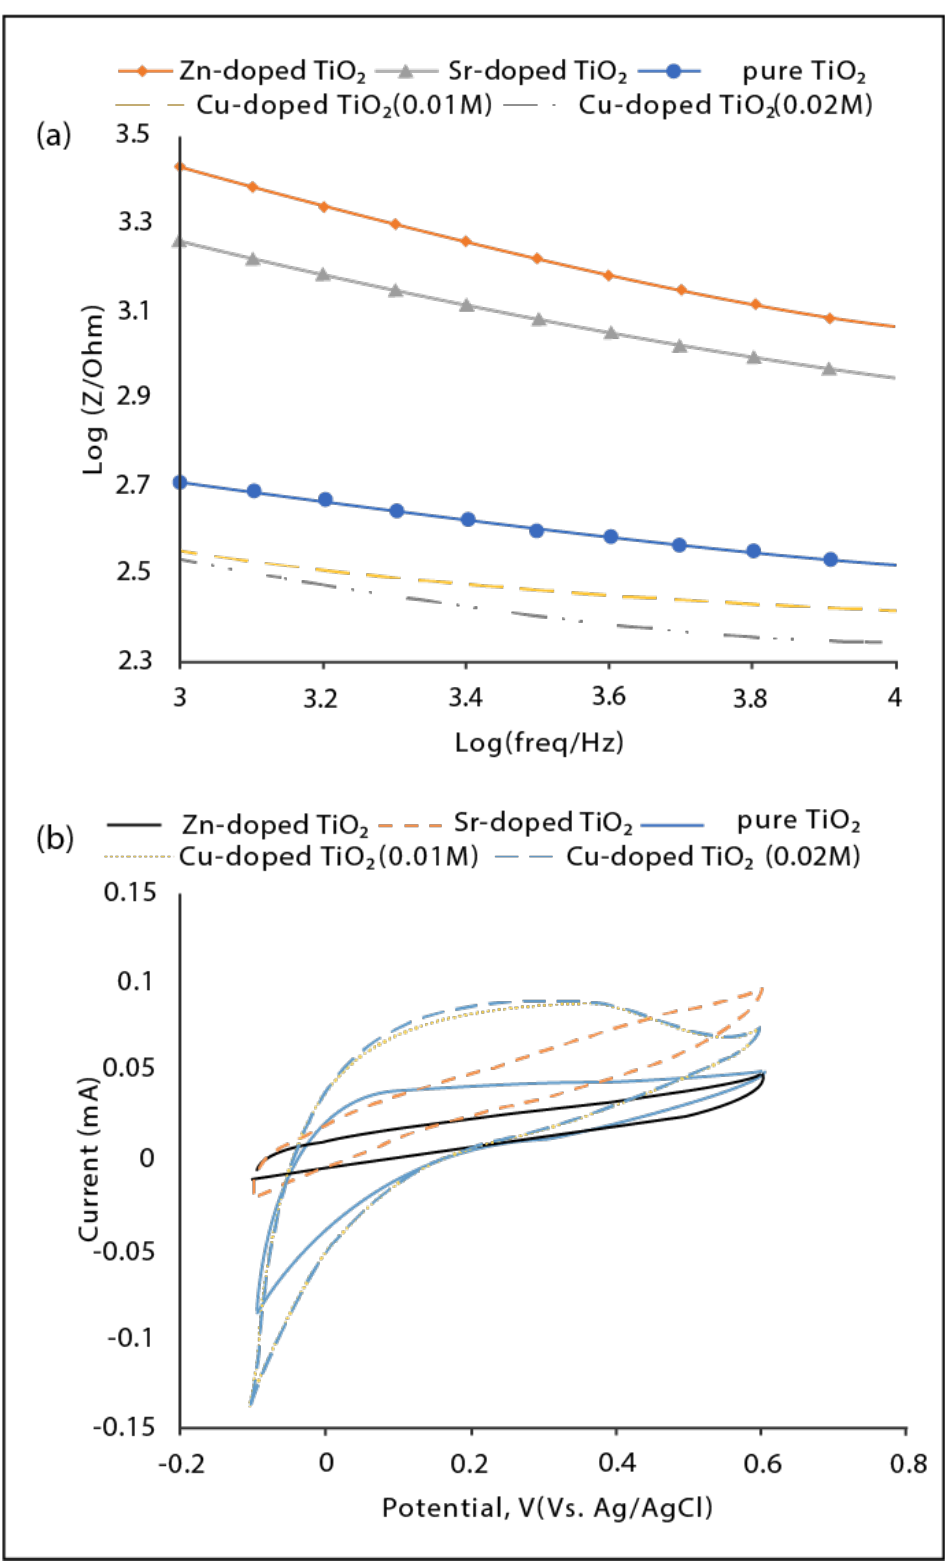
Figure 4. Electrochemical properties of pure and doped TiO 2 nanotube arrays after annealing ( a ) Bode impedance plots and ( b ) cyclic voltammograms obtained at a scan rate of 100 mV/s.